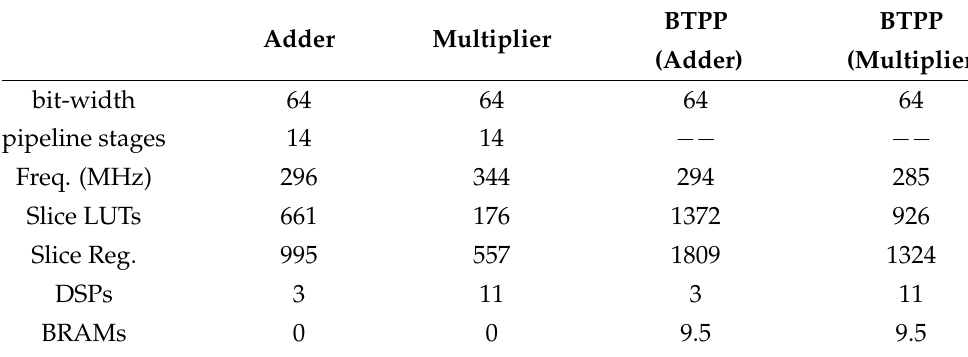
Table 2. BTPP with different reduction operators are implemented on Xilinx Artix-7